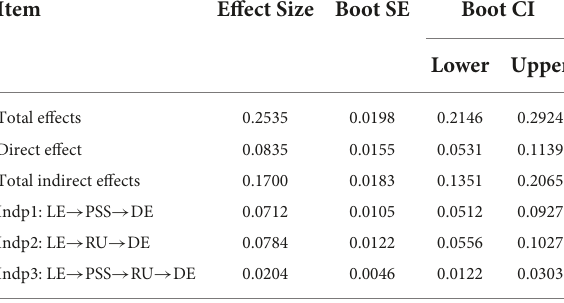
TABLE 3 Mediating effect test of rumination and perceived social support*.